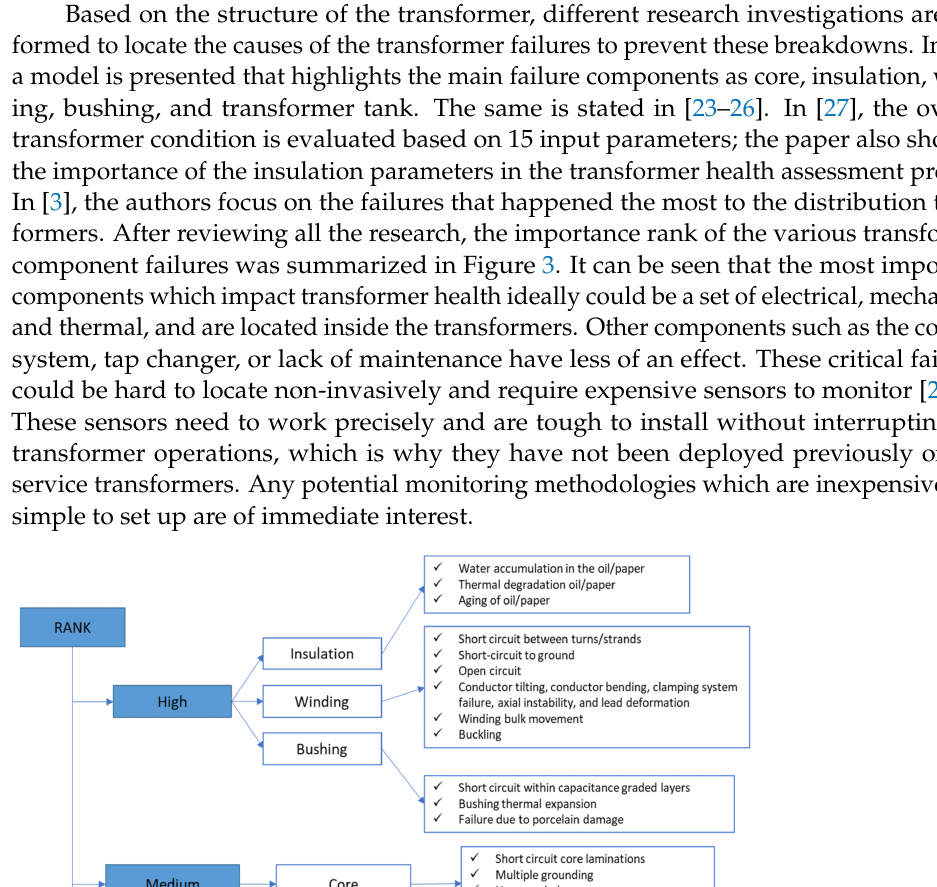
Figure 2. ( a ) Transformer structure and ( b ) structure of a single-phase oil-immersed service transformer.